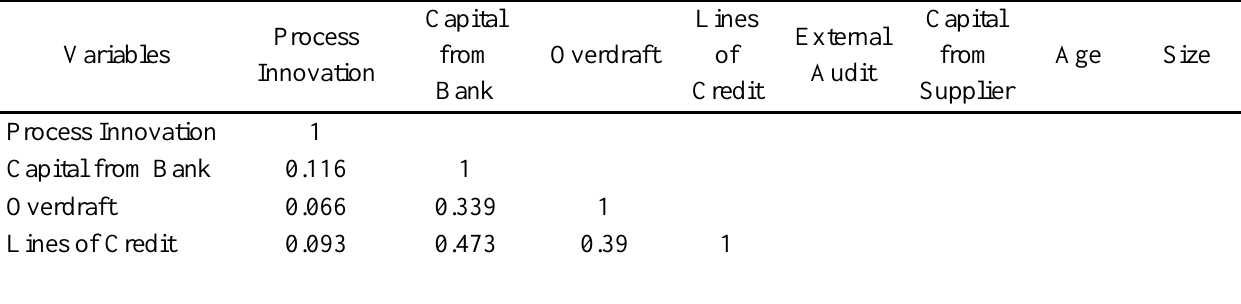
Table 3. Pairwise correlation between independent variables in access to credit and process innovation